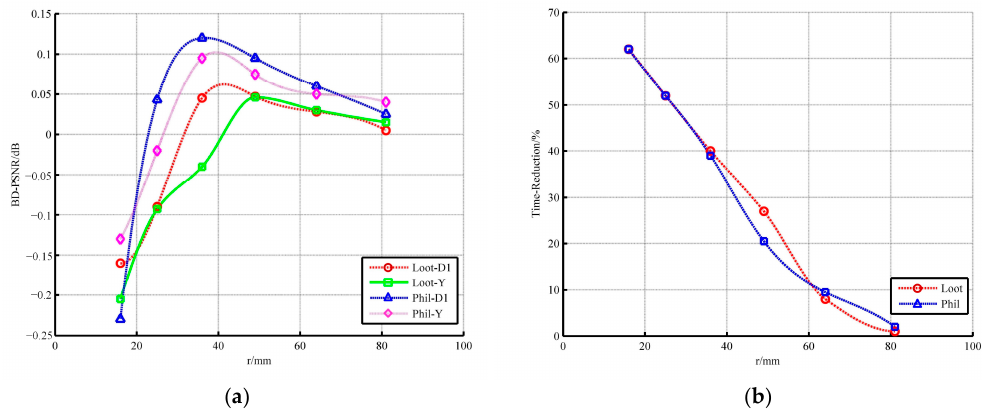
Figure 10. The influence of radius on ( a ) R.D. performance; ( b ) time.